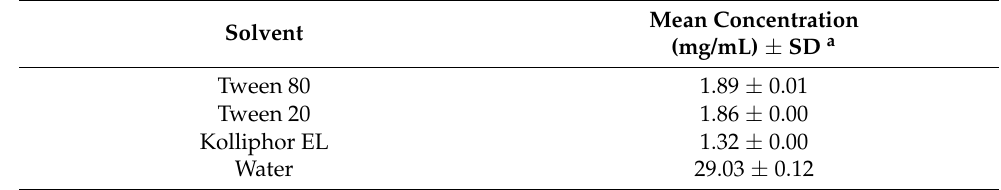
Table 2. Solubility of propranolol hydrochloride in various solvents at 37 ◦ C ( n =